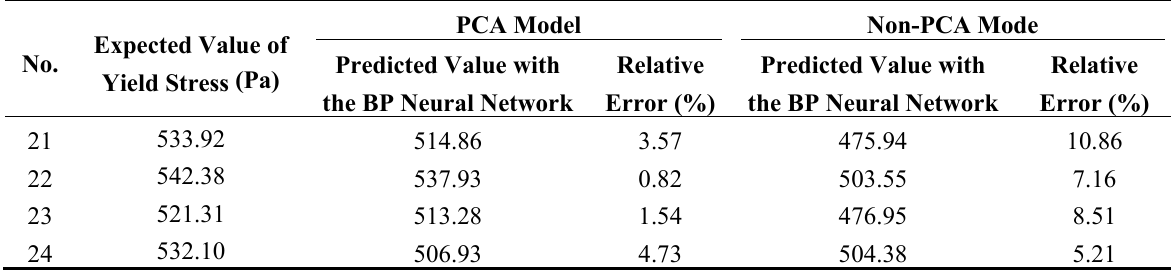
Table 11. Comparisons of predicted yield stress between the PCA model and the non-PCA model.